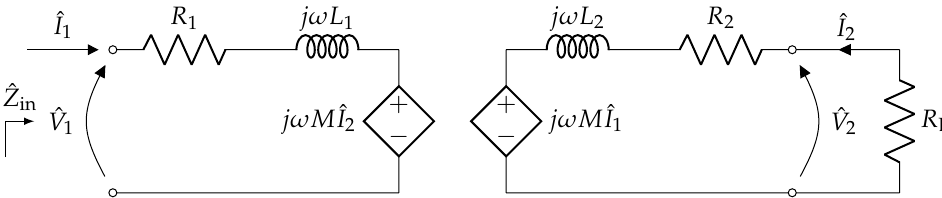
Figure 3. Equivalent circuit of the rotary transformer with mutual inductor: phasor